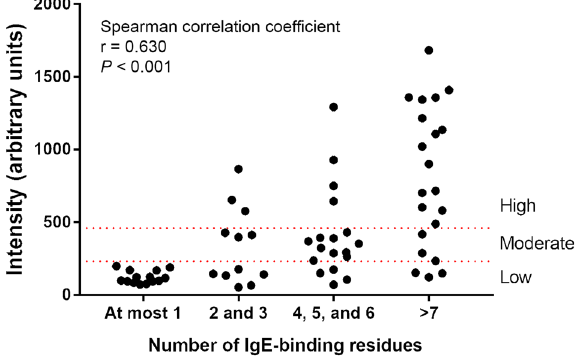
Figure 4. Nonparametric Spearman correlation analysis shows the positive correlation between intensity (arbitrary units) of rDer p 23-specific immunoglobulin E-positive individuals with the number of IgE-binding residues (Spearman correlation coefficient, r = 0.630; P < 0.001).